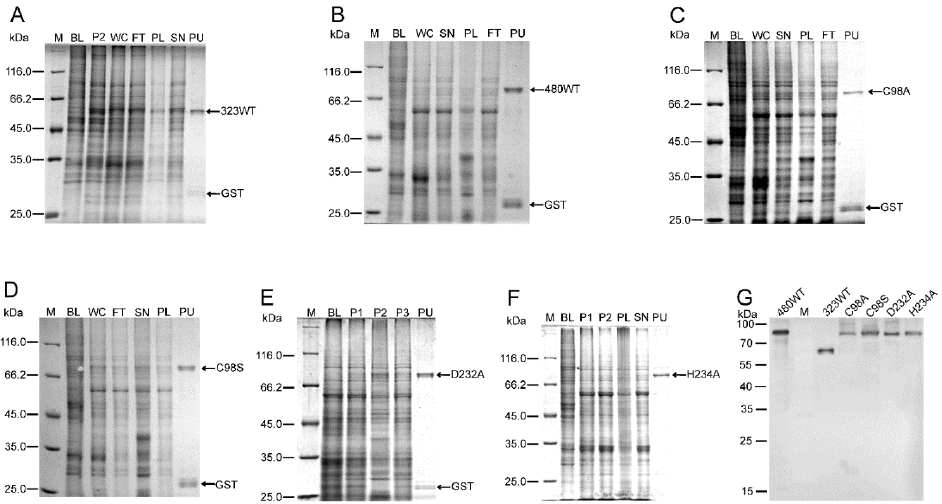
Figure 2. The expression and purification of wild type and mutants of UL36-DUBs. (A − F) , the SDS- PAGE gel images of expression and purification of UL36(323)-GST, UL36(480)-GST, and the mutants. (G) A Western blot image of purified UL36-DUBs using the anti-UL36(323) antibody. The lane labels: whole cells expressing target protein; FT refers to the flow-through of the purification column; SN refers to the supernatant of cell lysate; PL refers to the pellet of cell lysate; PU refers to the purified target protein; P1, P2, and P3 refer to sf9 cells used in the preparation of P1, P2, and P3 generation baculovirus, respectively; 480 WT refers to wild type UL36(480); 323 WT refers to wild type UL36(323); and C98A, C98S, D232A, and H234A refer to UL36(480) C98A , UL36(480) C98S , UL36(480) D232A , and UL36(480) H234A mutant proteins,